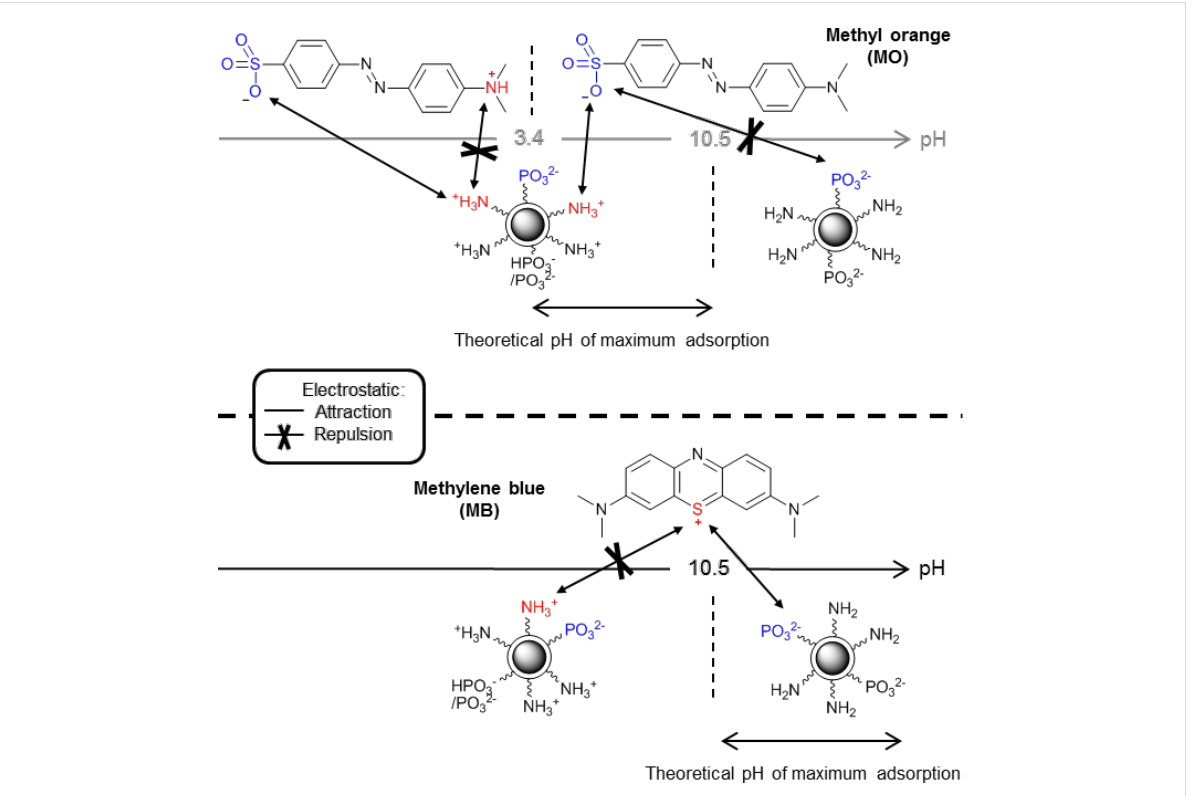
Figure 3: Prediction of the best range of pH values for electrostatic attractions between NP-PEIP and MO and MB dyes. Only the major interaction (i.e., ammonium) is represented. For MO, an interaction occurs with sulphates and ammonium groups, until the p K a (NH 3+ /NH 2 ) is reached. Cationic MB is attracted by the phosphonate groups introduced on PEI at basic pH values.